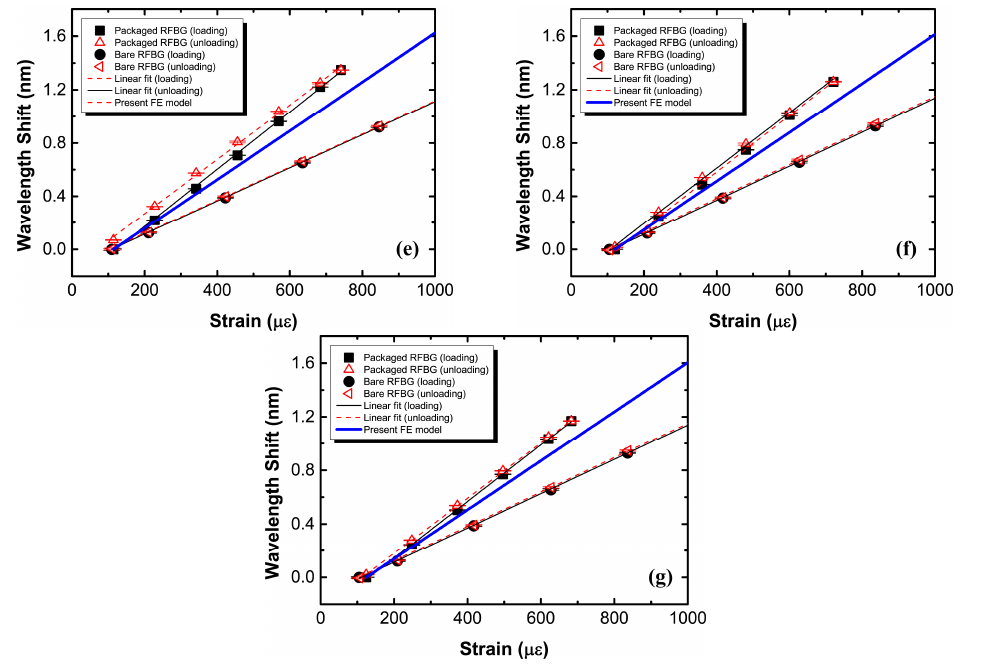
Figure 9. Shift in the Bragg wavelength as a function of strain obtained from tensile tests at constant temperatures of 26.5 °C ( a ); 100 °C ( b ); 200 °C ( c ); 300 °C ( d ); 400 °C ( e ); 500 °C ( f ) and 540 °C ( g ). FE: finite element.